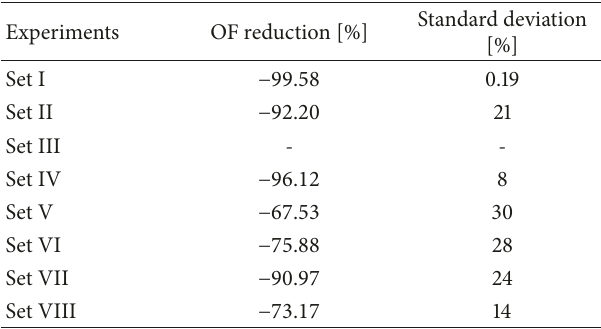
Table 2: Efficacy of the O–D estimation method in terms of OF